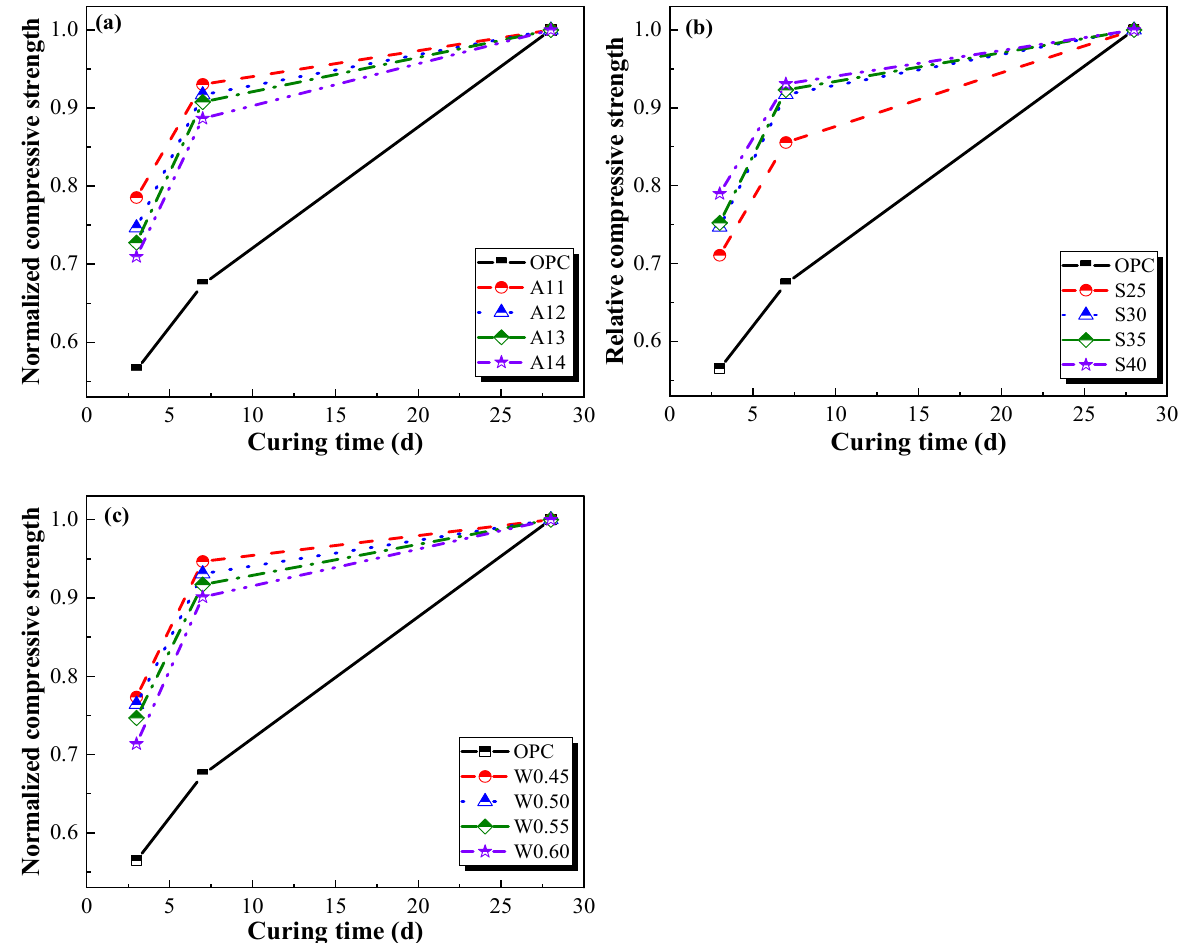
Figure 3. Normalized compressive strength of various specimens: ( a ) alkali content; ( b ) slag content; ( c ) water-to-binder ratio.